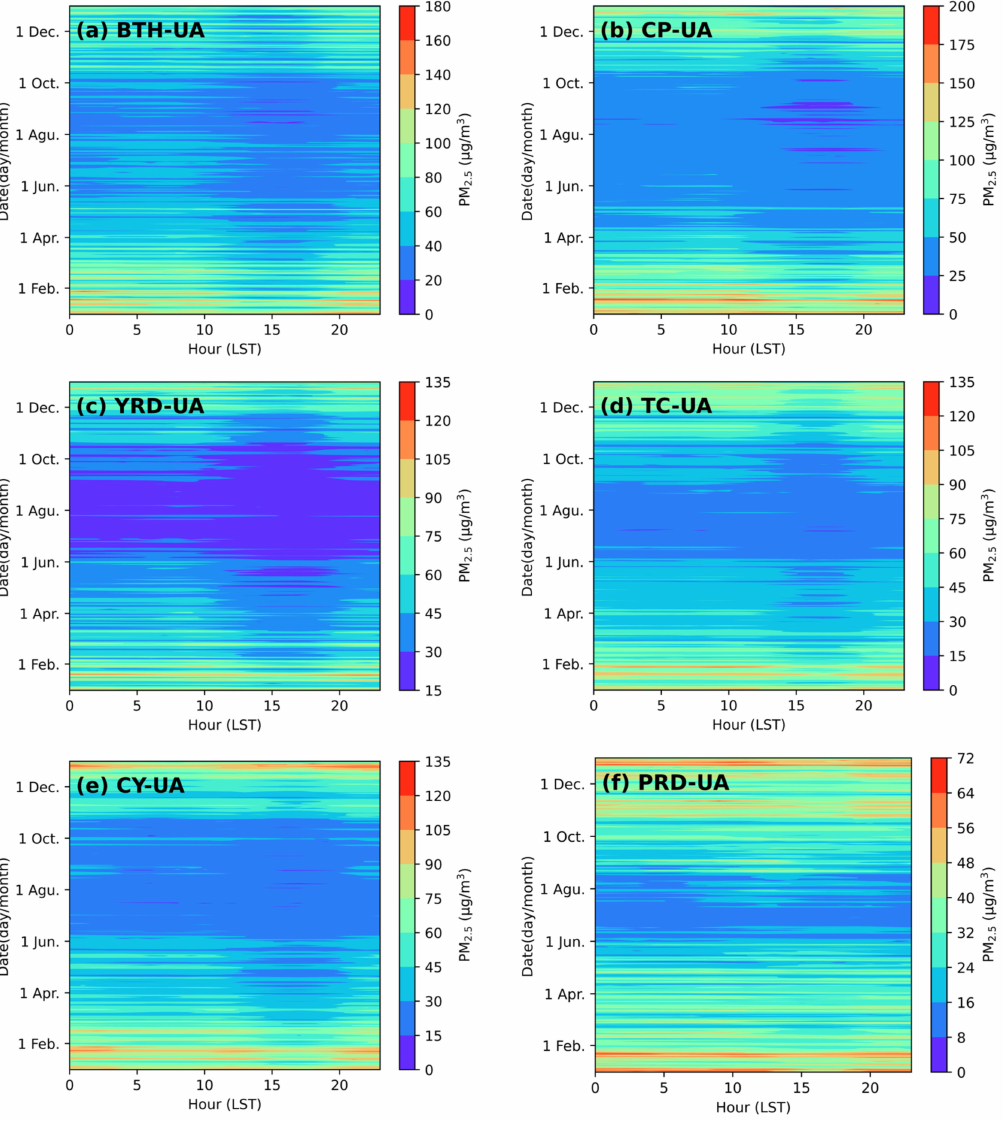
Figure 4. Diurnal changes in PM 2.5 concentrations on different days over the period of 2017–2020 in six urban agglomerations of China. ( a ) BTH-UA, ( b ) CP-UA, ( c ) YRD-UA, ( d ) TC-UA, ( e ) CY-UA and ( f )